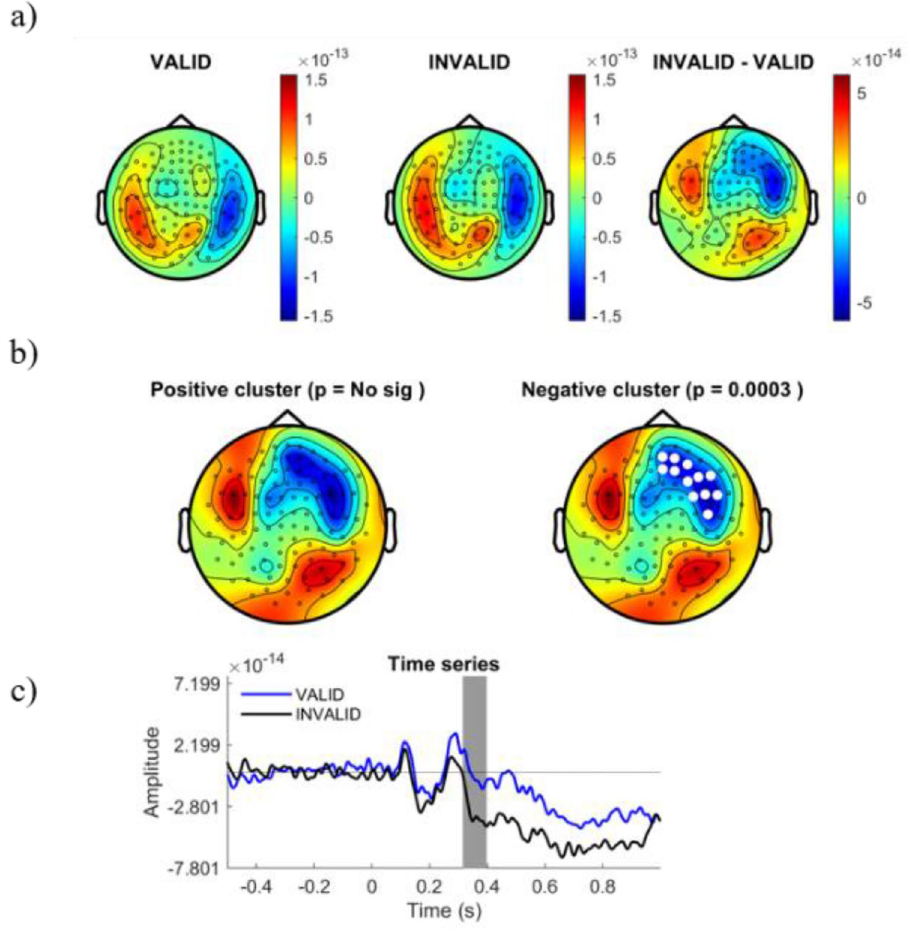
Figure 4. Represents the distribution of cortical activity in a time-slice from 250 to 400 ms. ( a ) Shows topographical maps of amplitudes for each condition (left and central map) and their arithmetic subtraction (right map). ( b ) Represents statistical differences (T values) between conditions. Left, positive cluster, and right, negative cluster. White dots represent sensors that showed significant differences during time-window. ( c ) Shows the whole time-series for both conditions (blue = VALID; black = INVALID). Grey mask represents time- slice of samples with significant